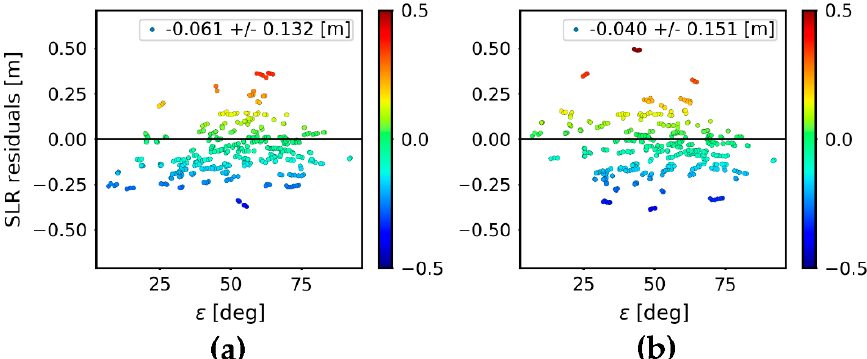
Figure 6. One-way SLR residuals of solutions using the a priori ( a ) cuboid model and ( b ) fast Fourier transformation (FFT) model for BeiDou-3 I2-S with respect to ε angle.